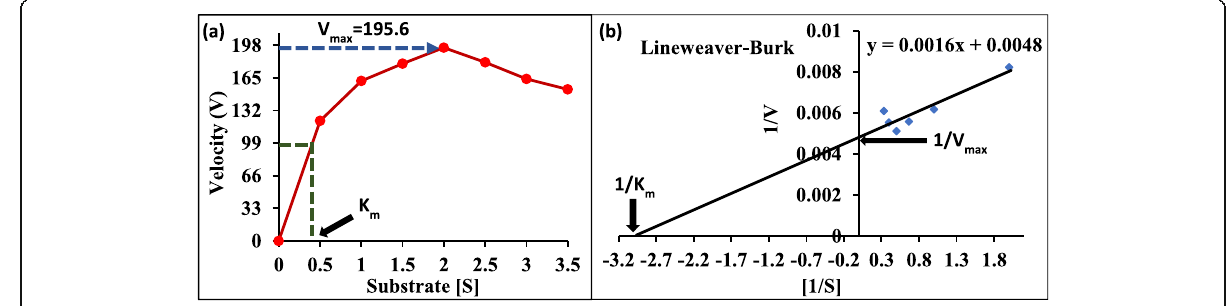
Fig. 2 Kinetic plots based on the specific substrate for purified lipase produced by Rhizopus oryzae R1 using the Michaelis-Menten ( a ) and Lineweaver-Burk plot ( b )